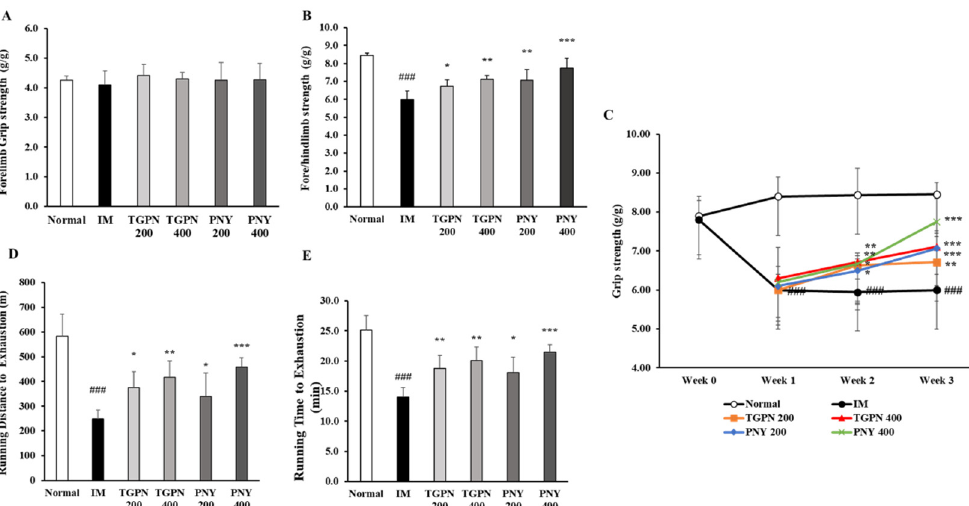
Figure 4. Effect of TGPN and PNY on muscle function in hindlimb immobilization-induced muscle atrophy mice. Mice were subjected to hindlimb immobilization for one week, except for the normal group, and then administered with TGPN 200, 400 mg/kg, or PNY 200, 400 mg/kg for two weeks with continuous immobilization. ( A ) The forelimbs grip strength. ( B ) The fore/hindlimbs grip strength. ( C ) The grip strengths curve. The grip strengths were normalized to the bodyweight. ( D ) Running distance on the treadmill. ( E ) Running time on the treadmill. Data are presented as the mean ± SD. ### p < 0.001 versus normal, * p < 0.05, ** p < 0.01, *** p < 0.001 versus IM.